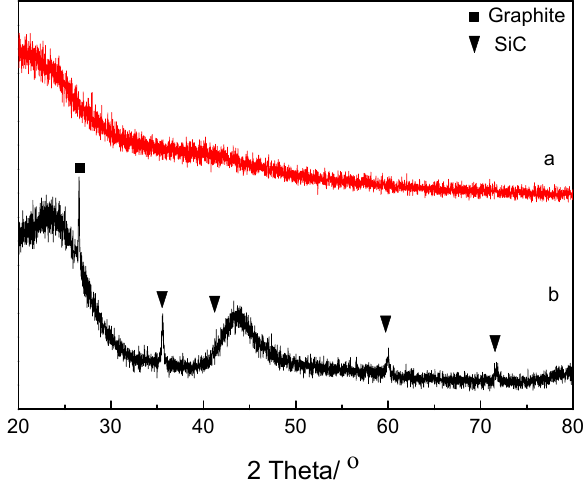
Figure 3. X-ray diffractograms of hydrochar from glucose ( a ) and a core-shell C-SiC composite ( b ). The broad peaks at about 24° and 44° are typical for amorphous carbon.